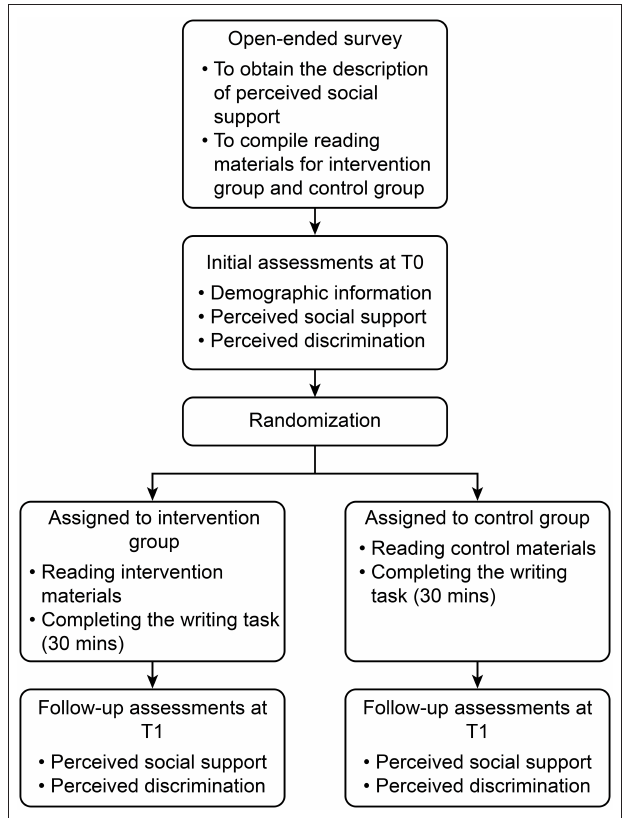
FIGURE 2 | Diagram of the study